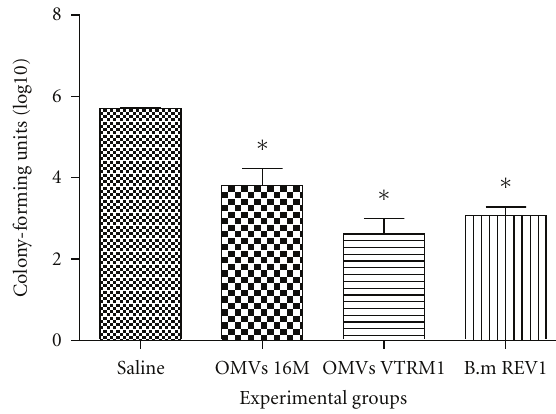
Figure 3: Analysis of IgG1 (a) and IgG2a (b) antibody responses of BALB/c mice to outer membrane vesicles from Brucella . Outer membrane vesicles (OMVs) were purified from B. melitensis 16 M and B. melitensis VTRM1, and mice were immunized. Sera from each mouse were collected and were assayed individually by ELISA. Antibody levels are expressed as optical density (OD) at 492